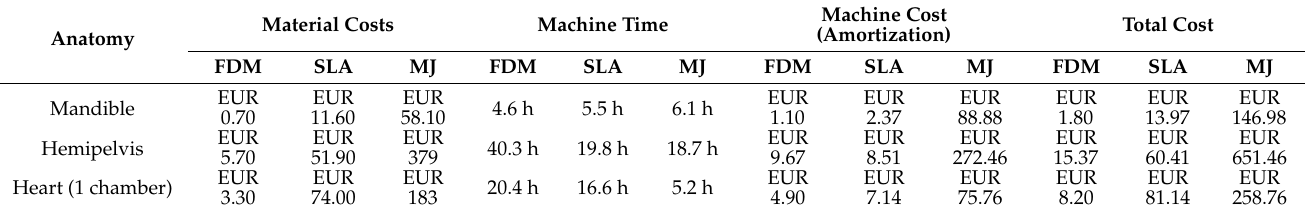
Table 3. Material and machine costs.